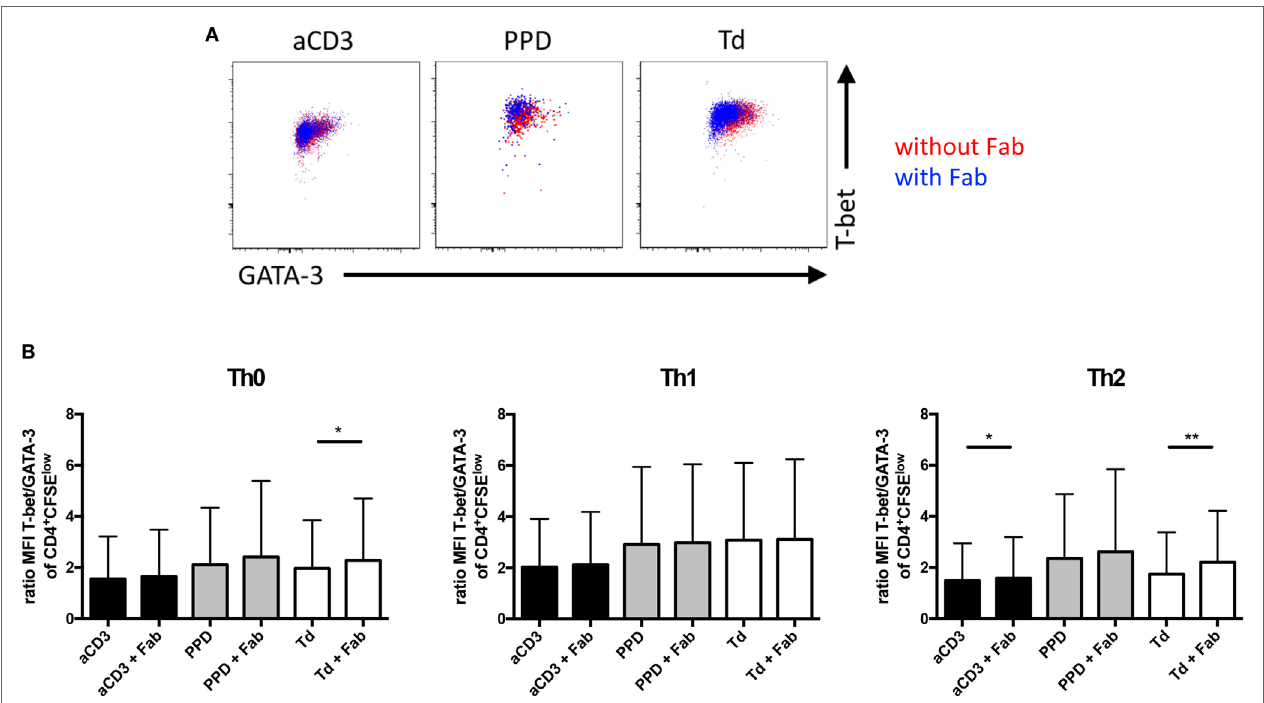
FigUre 6 | CD28 co-stimulation favors GATA-3 over T-bet expression in tetanus and diphtheria toxoid-specific human memory CD4 + T cells upon antigenic recall under Th2 conditions in vitro . Additional analysis of experiments presented in Figure 4 . (a) Representative FACS data of GATA-3 and T-bet expression in CD4 + T cells cultured in the absence (red) or presence (blue) of CD28.3-Fab. (B) Normalized ratio of median fluorescence intensity (MFI) T-bet/MFI GATA-3 in proliferated CD4 + carboxyfluorescein succinimidyl ester diacetate low cells cultured under Th0 (left), Th1 (middle), or Th2 (right) culture conditions. Graphs show mean + SD from 19 donors assayed individually and tested with a one-tailed paired t -test (* p < 0.05, ** p <